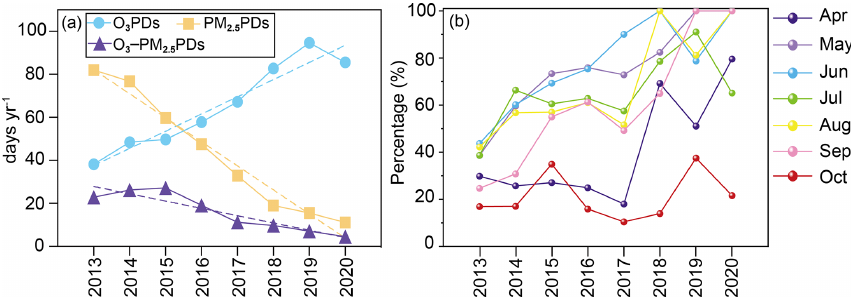
Figure 2. (a) The trends of observed O 3 PDs, PM 2 . 5 PDs, and O 3 –PM 2 . 5 PDs in warm seasons from 2013 to 2020 averaged over all sites in BTH. The blue, yellow, and purple solid lines (dashed lines) represent the numbers (liner trend) of O 3 PDs, PM 2 . 5 PDs, and O 3 –PM 2 . 5 PDs, respectively. (b) The percentage of O 3 –PM 2 . 5 PDs on PM 2 . 5 PDs for April to October in 2013 to 2020. The polluted days were averaged over all sites in